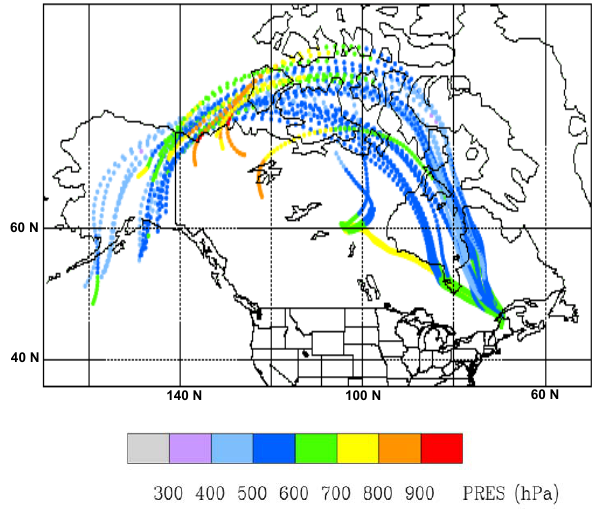
Fig. 15. HYSPLIT 5-day ensemble back trajectory based on GDAS 1 ◦ X 1 ◦ meteorological data initiated from enhanced 681hPa TES CO observation at 1700 UTC June 15, 2005. The colors indicate the altitudes of the trajectories in pressure